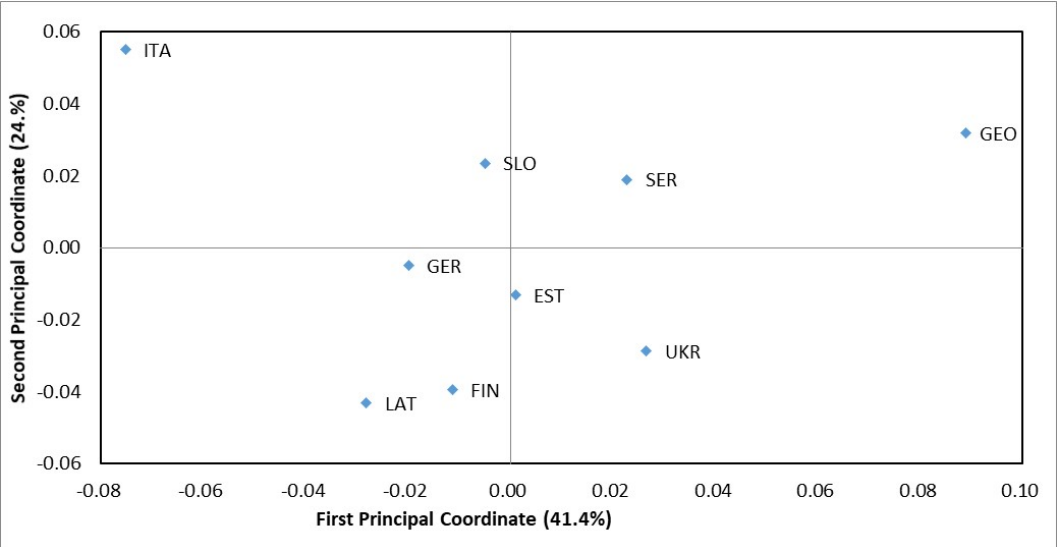
Figure 3. Principal coordinate analysis of Nei’s genetic distance of nine subpopulations of D. sapinea . The variation explained by each coordinate is given as a percentage within parentheses. Subpopulation codes: Estonia—EST, Finland— FIN, Georgia—GEO, Germany—GER, Italy—ITA, Latvia—LAT, Serbia—SER, Slovakia—SLO and Ukraine—UKR.